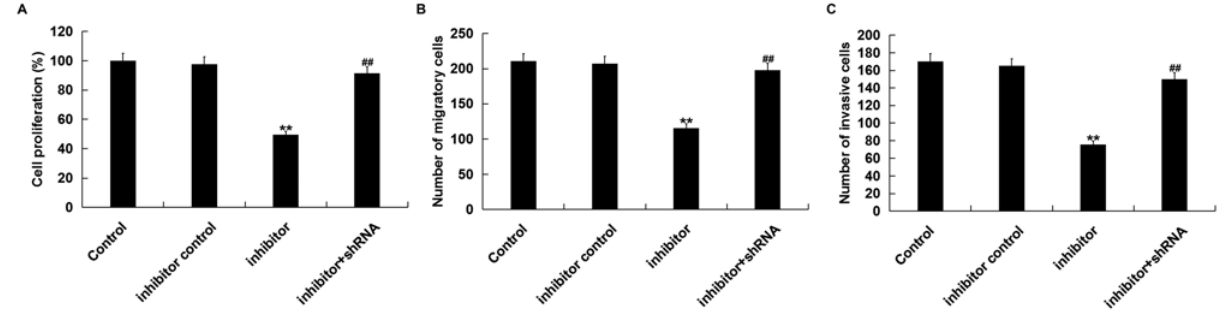
Figure 5: MiR-663b inhibitor inhibited Jurkat cell proliferation, migration and invasion ability. Jurkat cells were transfected with inhibitor control, miR-663b inhibitor or miR-663b inhibitor+CD99-shRNA for 48 h. (A) MTT assay was carried out to determine cell proliferation; (B and C) Transwell assay was carried out to determine cell migration and invasion ability. The data were expressed as the mean ± SD. **p<00.01 vs. Control; ##p<00.01 vs.